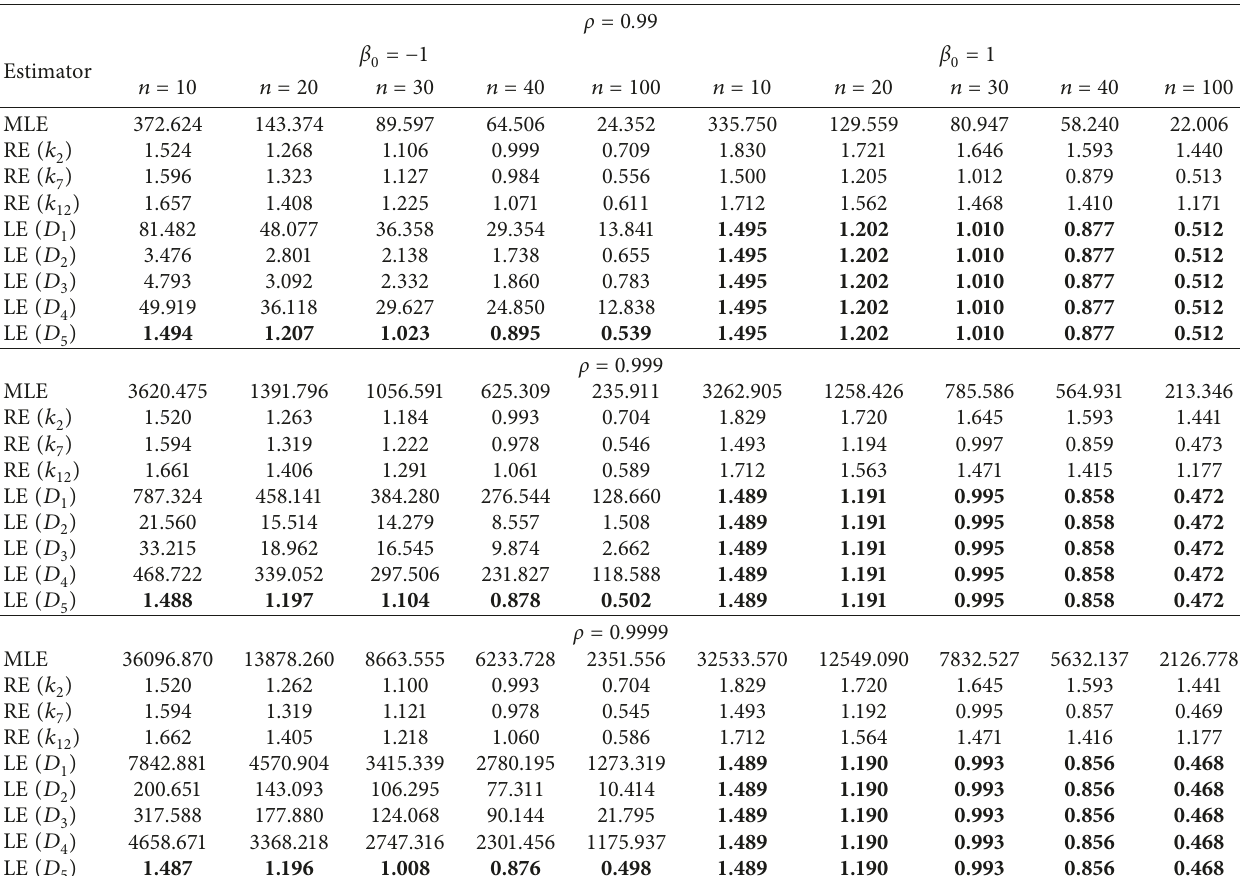
Table 5: Estimated SMSE values for different n, ρ ,k, d, and β